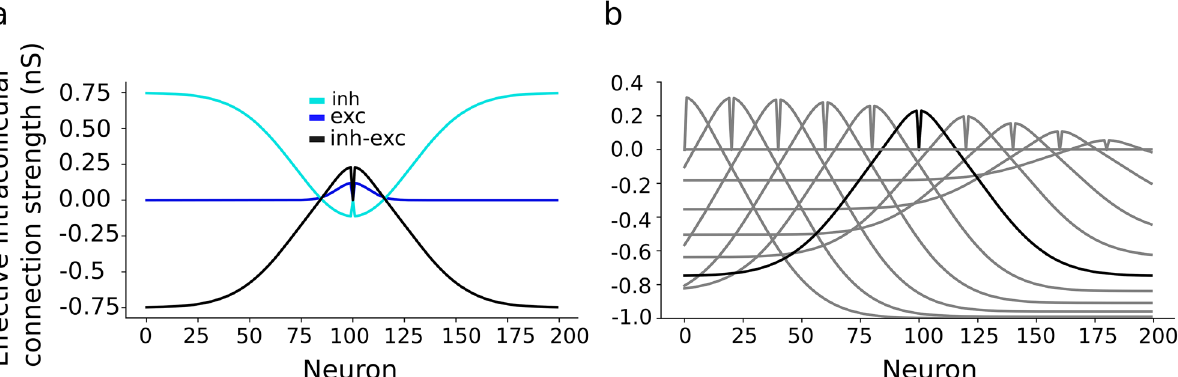
Figure 4. ( a ) The excitatory (σ exc = 0.2 mm; dark-blue) and inhibitory (σ inh = 0.7 mm; light-blue, shown inverted) intra-collicular synaptic connections, and their total effect (black line) for central neuron at neural population generating 15 deg saccade, result in a symmetric local excitatory and global inhibitory connectivity. The net excitation around the neuron (at 0) approaches the value of + 0.23. ( b ) Total effect of excitatory and inhibitory intra-collicular synaptic connections for neurons across motor map generating different saccade amplitude. The intra-collicular synaptic connections are stronger towards the rostral zone (thus counter-acting the higher firing rates) than towards the caudal zone (where cells have lower firing